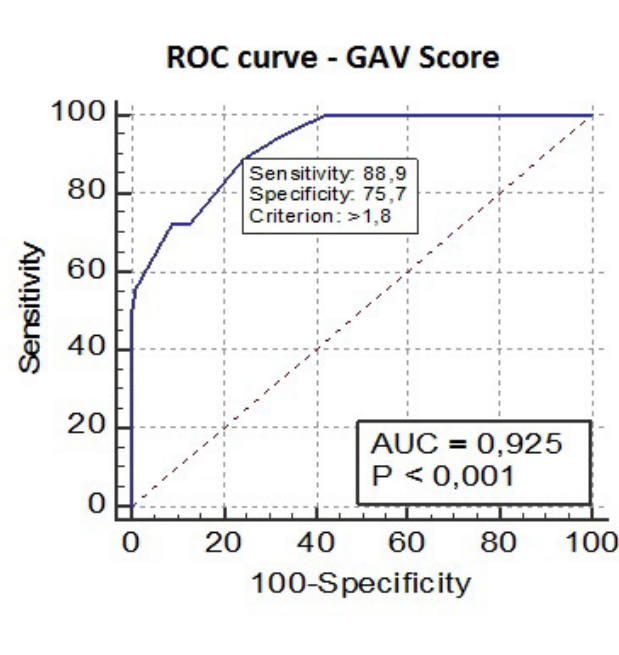
Fig. 2 – Receiver operating characteristic (ROC) curve – Accuracy. AUC=area under the ROC curve; GAV=German Aortic